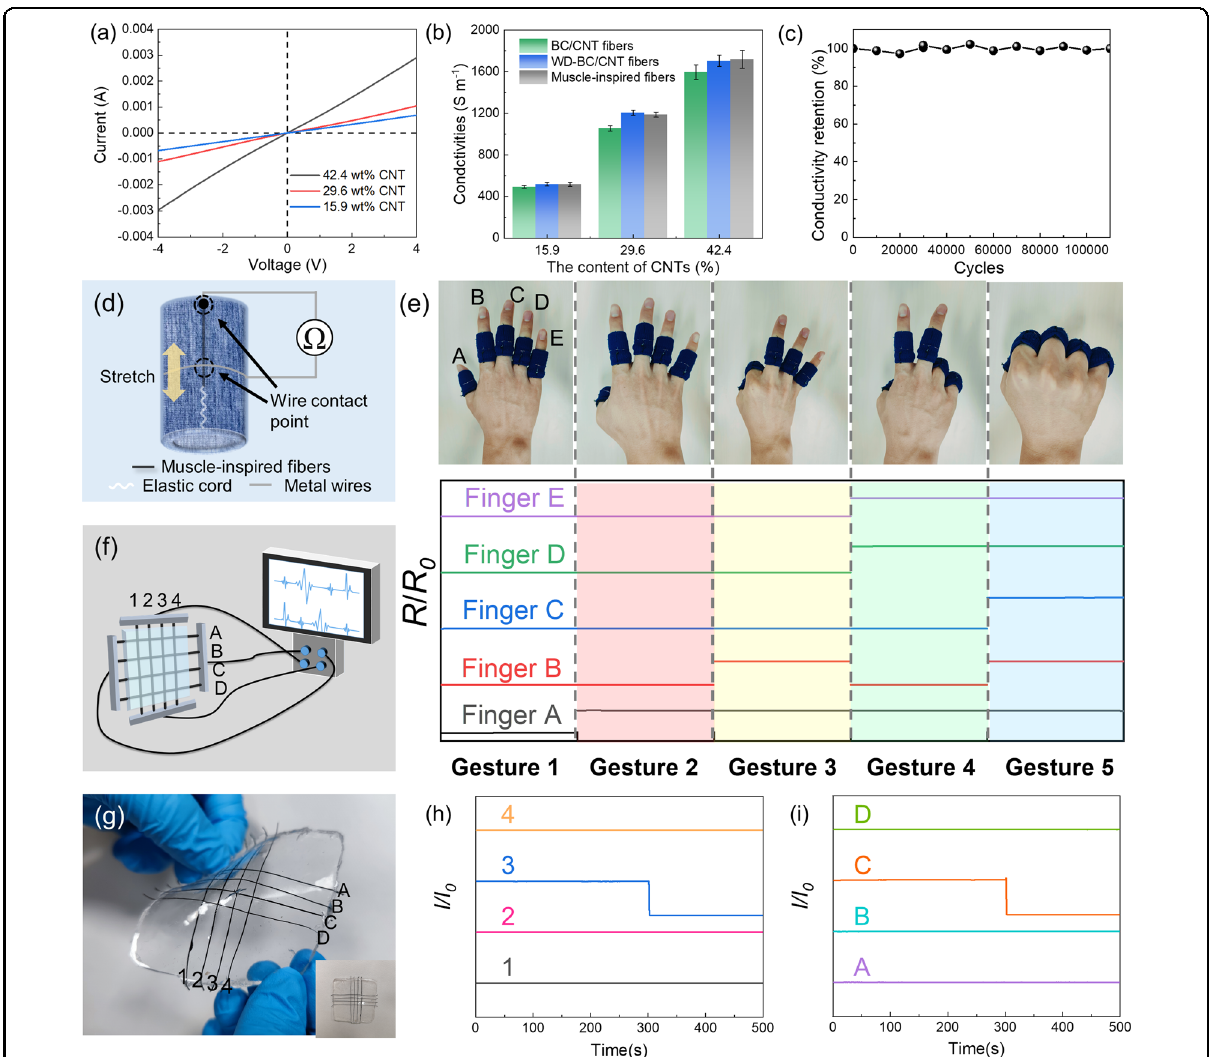
Fig. 5 The electrical properties and sensing performance of the muscle-inspired fi bers. a Typical I – V curves of muscle-inspired fi bers with different CNT contents showing their pure resistance. b The electrical conductivity of the muscle-inspired fi bers, WD-BC/CNT fi bers and BC/CNT fi bers with different CNT contents. c The electrical conductivities of the muscle-inspired fi bers after different numbers of bending test cycles. d Schematic illustration of the fi ber-based smart fi ngerstalls. e Photograph of the muscle-inspired fi ber-based smart fi ngerstalls worn on the hand. The upper wire contact point is fi xed, and the middle wire contact point is slidable. Different letters correspond to the fi ngerstalls on different fi ngers. With the change in gestures, the muscle-inspired fi ber-based smart fi ngerstalls provide different signals through the current. The signals re fl ect the resistance changes of the muscle-inspired fi bers between the two wire contact points. f Schematic illustration of the conductive fi ber-based composite with a sensing function. g The muscle-inspired fi ber-based composite after damage. The inset photograph is the muscle-inspired fi ber-based composite before damage. h, i The self-monitoring of the muscle-inspired fi ber-based composite through electric current. The signals re fl ect the current changes of muscle-inspired fi